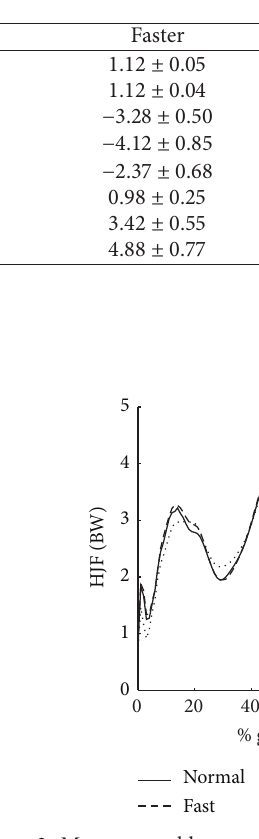
Table 2: Group means ± SD for discrete ground reaction forces (GRF) and hip joint reaction forces (HJF). All force variables are presented in bodyweights (BW).